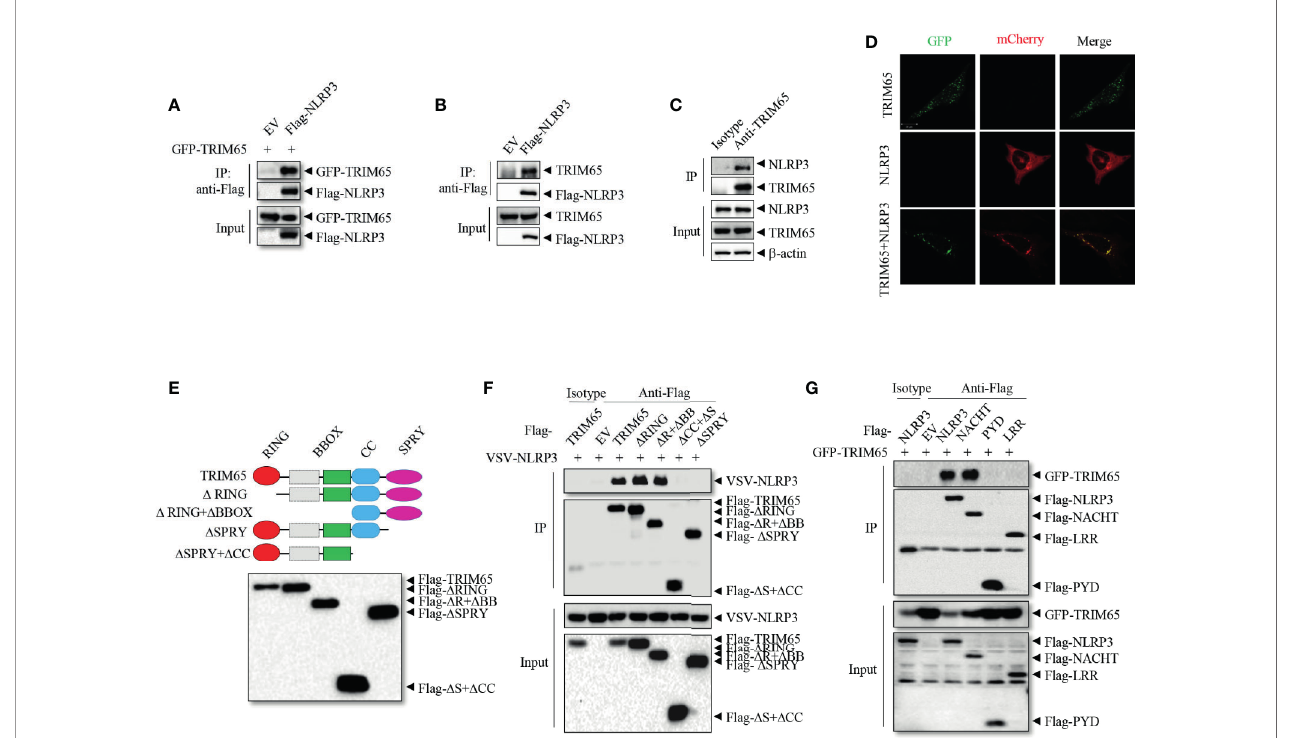
FIGURE 1 | TRIM65 interacts with NLRP3. (A) Flag-NLRP3 was cotransfected with GFP-TRIM65 in HEK-293T cells. The interaction between NLRP3 and TRIM65 was analyzed by immunoprecipitation and western blotting. (B) Flag-NLRP3 was transfected and expressed in HEK-293T cells. The interaction between NLRP3 and endogenous TRIM65 was assayed by immunoprecipitation and western blotting. (C) The lysates of PMA-differentiated and LPS-primed THP-1 cells were immunoprecipitated with anti-NLRP3 antibody, and the interaction between endogenous NLRP3 and endogenous TRIM65 was analyzed by western blotting. (D) mCherry-NLRP3 was cotransfected with GFP-TRIM65 in HEK-293T cells. The colocalization of NLRP3 and TRIM65 was assayed by confocal microscopy. Bars: (white) 20 mm. (E) Diagram of full-length TRIM65 and TRIM65 deletion mutants ( D RING, D R+ D BB, D CC+ D S or D SPRY). (F) Flag-TRIM65 and TRIM65 deletion mutants were individually cotransfected with VSV-NLRP3 in HEK-293T cells. The interactions between NLRP3 and TRIM65 or its different domains were analyzed by immunoprecipitation and western blotting. (G) Full-length or truncated Flag-NLRP3 (Flag-PYD, Flag-NACHT or Flag-LRR) was cotransfected with GFP-TRIM65 in HEK-293T cells. The interaction between TRIM65 and full-length or truncated NLRP3 was analyzed by immunoprecipitation and western blotting. Data are representative of three independent experiments. EV, empty vector; Input, cell extract without